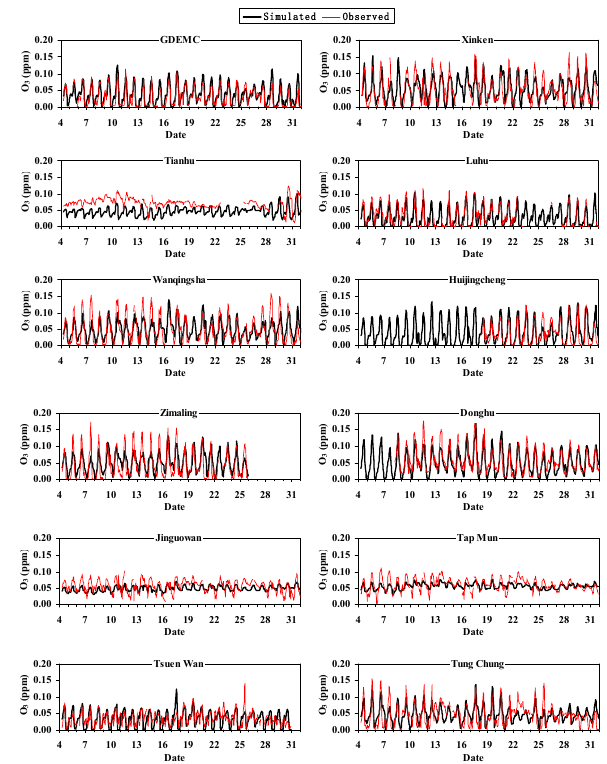
Fig. 3. Time series of simulated surface O 3 against that observed at PRD monitoring sites during 4–31 October